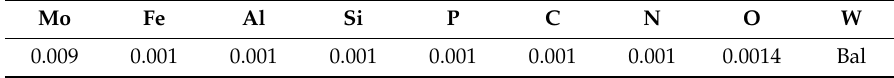
Table 1. The impurities with concentration over 0.001 wt.% in tungsten bulk.